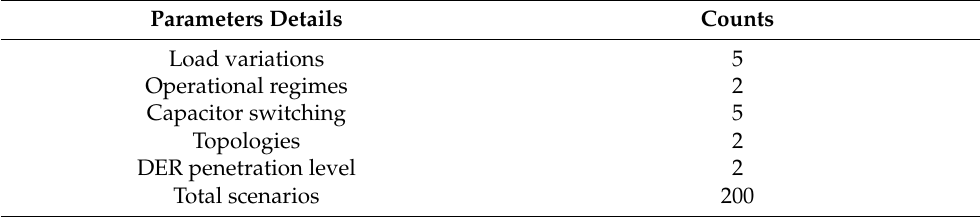
Table 1. Fault cases simulation conditions. Table 2. No-fault cases simulation